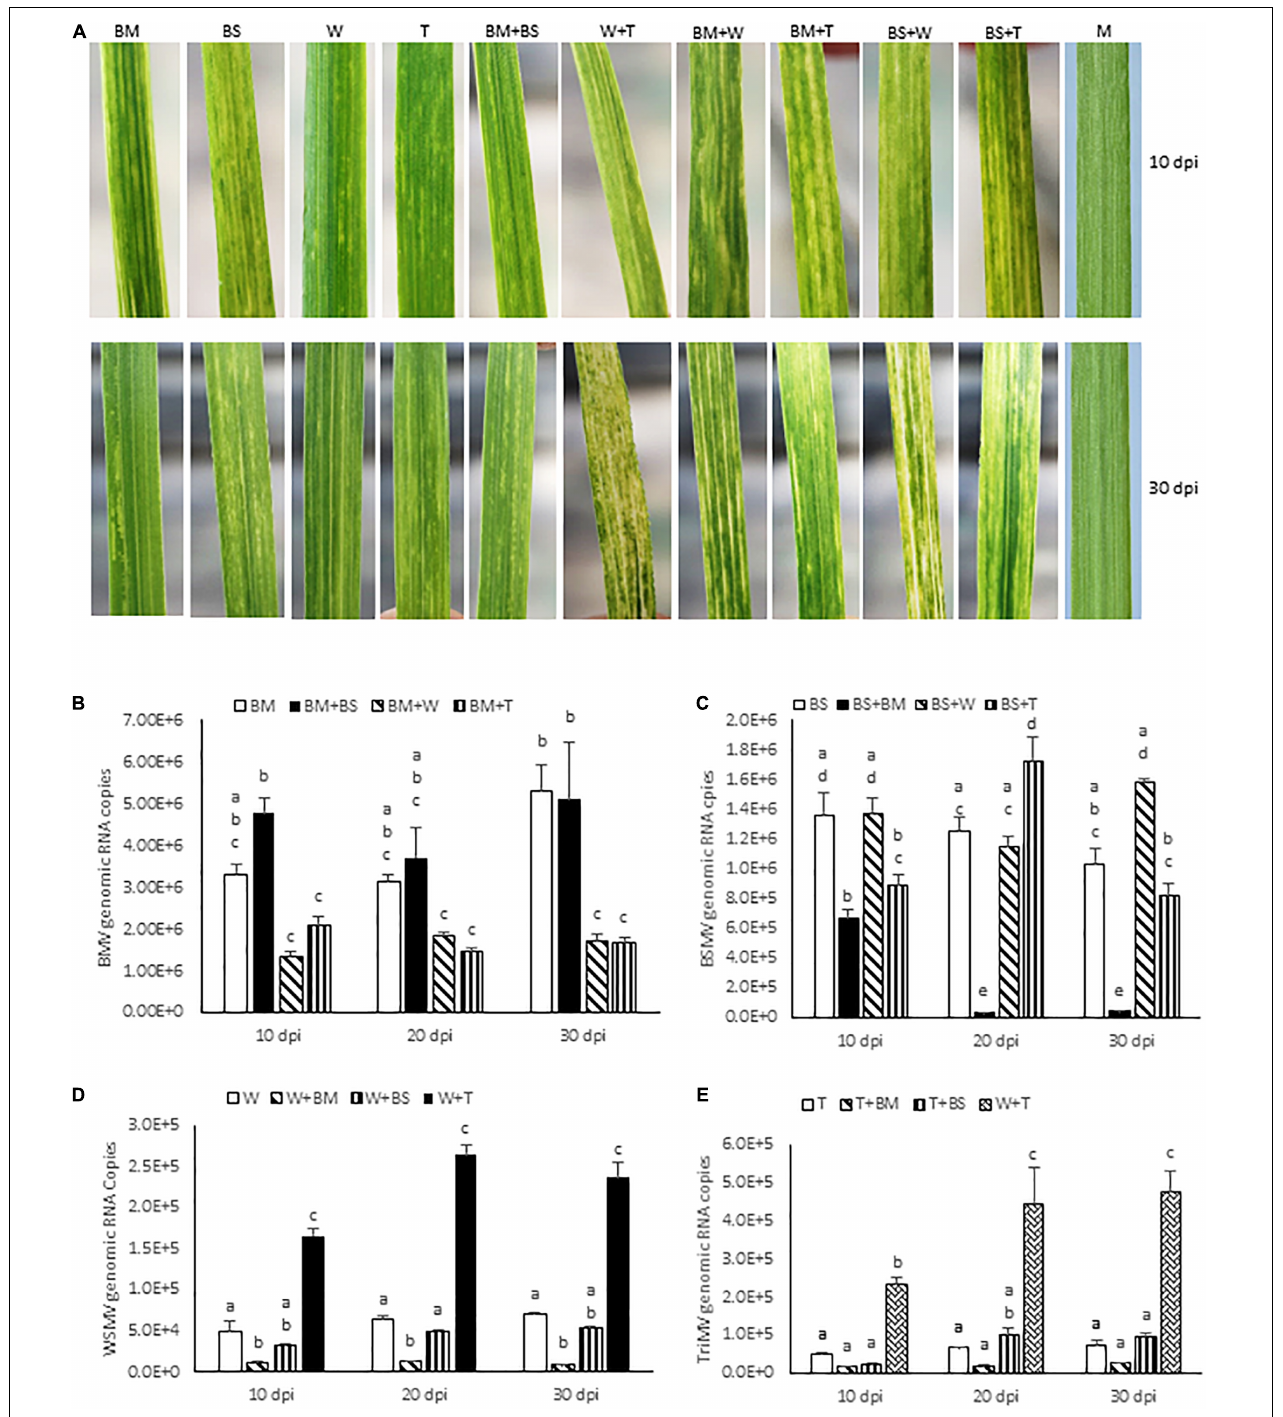
FIGURE 1 | Bipartite synergistic interactions among brome mosaic virus (BMV), barley stripe mosaic virus (BSMV), wheat streak mosaic virus (WSMV), and Triticum mosaic virus (TriMV) in wheat cv. Arapahoe. (A) Wheat leaves showing symptoms elicited by BMV, BSMV, WSMV, or TriMV in singly or doubly infected wheat at 10 and 30 days post-inoculation (dpi). Note that co-infection of wheat by BMV and BSMV elicited symptoms similar to those of BMV. (B–E) Absolute quantification of genomic RNA copies of BMV (B) , BSMV (C) , WSMV (D) , and TriMV (E) in singly or doubly infected wheat at 10, 20, and 30 dpi by real-time RT-PCR. Histograms indicate accumulation of viral genomic RNA copies in 2.5 ng total RNA with standard error. Note that accumulation of BSMV in BMV + BSMV infected wheat was reduced at 20 and 30 dpi compared to BSMV-infected wheat. The same letters above the histograms indicate non-significant, whereas different letters indicate significance at p = 0.05. M, Mock-inoculation; BM, BMV; BS, BSMV; W, WSMV; T, TriMV.